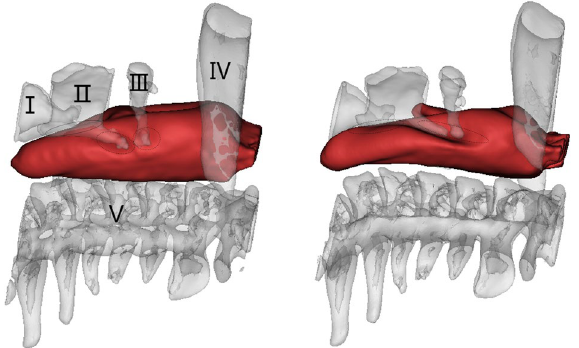
Figure 5. The 3D image of PB-LMA100 (left) and PB-LMA50 (right)( the cricoid cartilage (I), the thyroid cartilage (II), the hyoid bone (III), mandible (IV), the spine (V), and the mucosa inserted with an LMA).